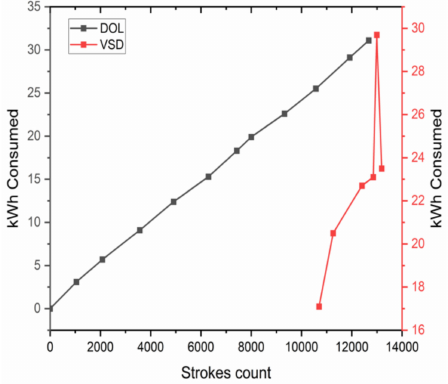
Figure 7. Electrical energy consumption variation with press stroke counts in DOL and VSD